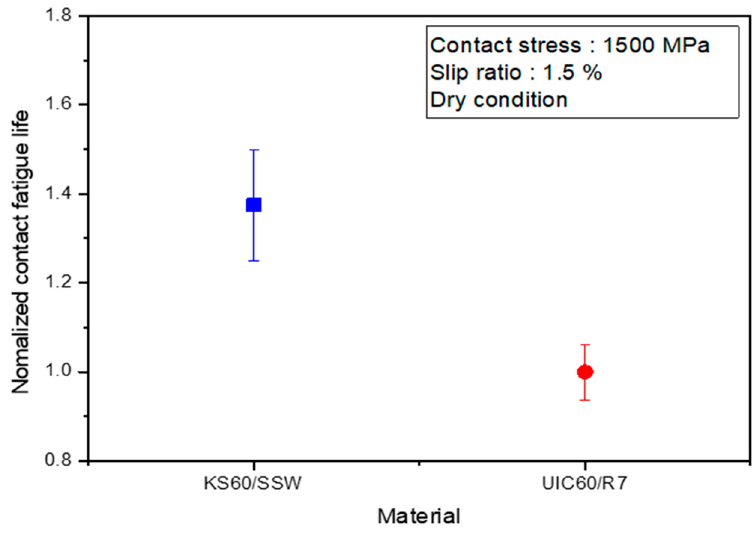
Figure 20. Contact fatigue test results.